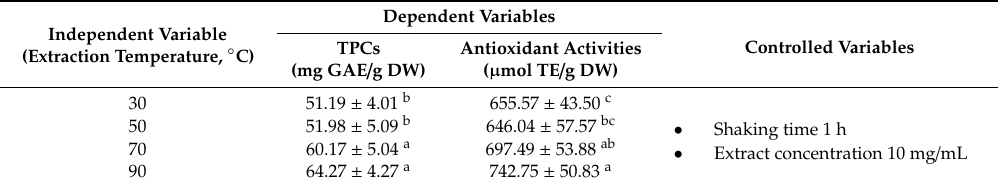
Table 3. E ff ects of di ff erent temperatures on sacred lotus stamen extraction regarding total phenolic contents (TPCs) and antioxidant activities determined by FRAP